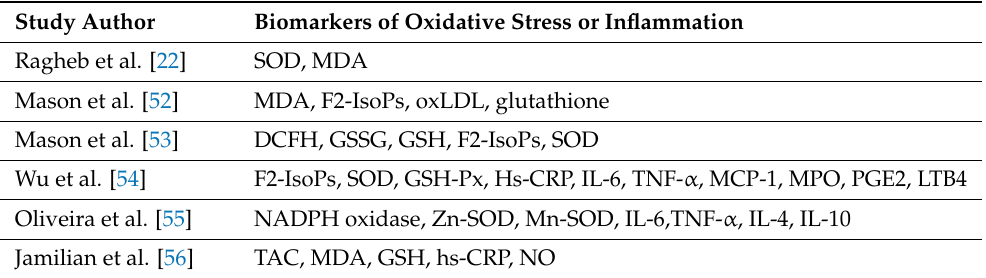
Table 2. Biomarkers That Have Been Studied to Determine the Antioxidant and/or Anti-inflammatory Properties of a Particular Fruit